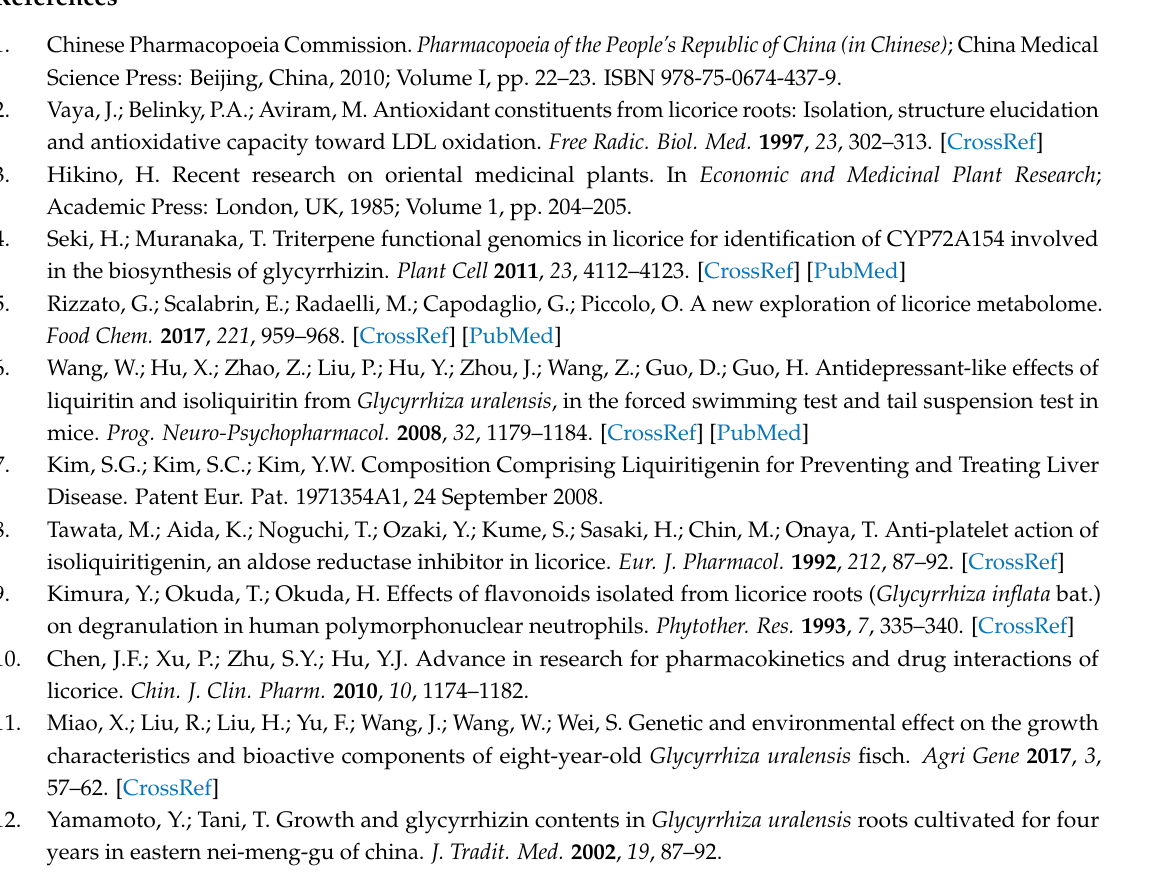
Supplementary Materials: Supplementary materials are available online. Table S1: Average Plant height, Stem diameter, Root length, Root diameter and Root weight from control and ABA treated G. uralensis . Table S2: Accumulation of active components in root of G. uralensis